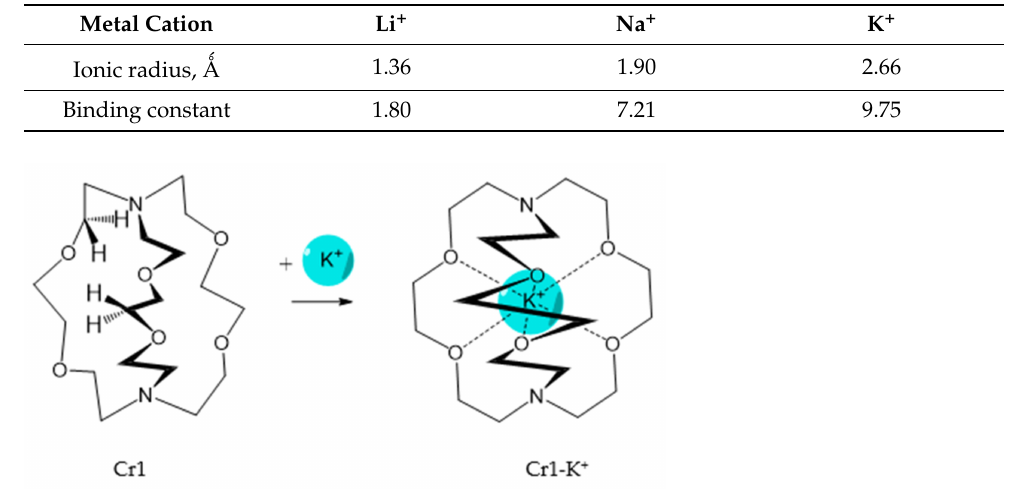
Table 7. Constants of binding (lg K a ) of alkali metal cations by cryptand-[2,2,2] in methanol at 25 ◦ C [110].